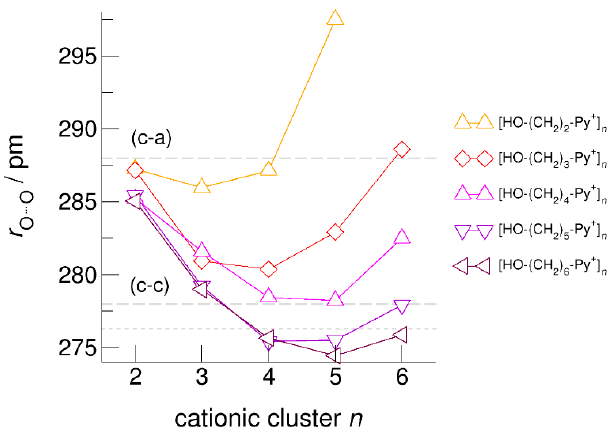
Figure 8. Average intermolecular bond lengths, r (O ... O) , for the cationic clusters [HO-(CH 2 ) x -Py + ] n with x = 2–6 and n = 2–6. For the clusters [HO-(CH 2 ) 6 -Py + ] n with the longest hydroxyalkyl chains, r (O ... O) is shortened by 10 ppm due to enhanced cooperative hydrogen bonding. For comparison, we show the average r (O ... O) distances of the pure ionic liquid [HO-(CH 2 ) 4 -Py][NTf 2 ] obtained from neutron di ff raction (grey dashed lines) along with those for the ring hexamer of liquid ethanol derived from X-ray di ff raction data (grey dotted line)